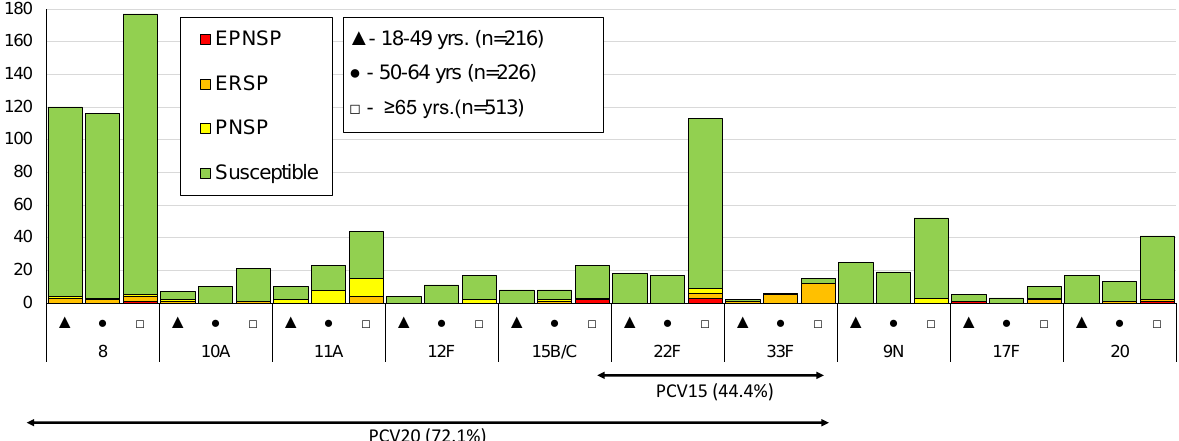
Figure 2. Isolates expressing serotypes present in PPV23 but not included in PCV13 causing invasive pneumococcal disease in adult patients (≥18 years) in Portugal from 2015 to 2018. See legend of Figure 1. Out of the 11 serotypes present in PPV23 but absent from PCV13, serotype 2 was not found in our collection.